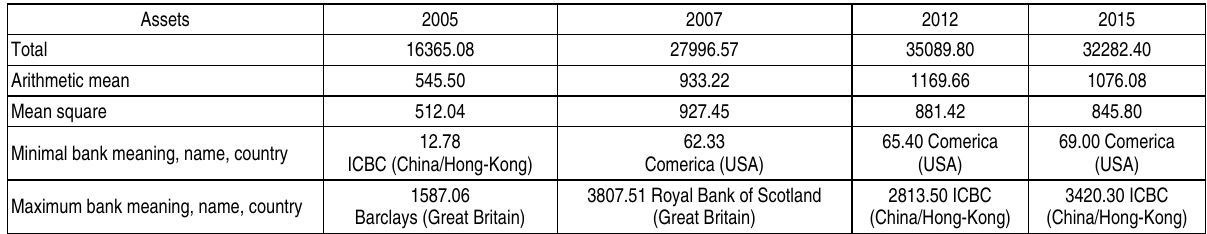
Table 4. The dynamics of assets volume of thirty major world banks, bln US